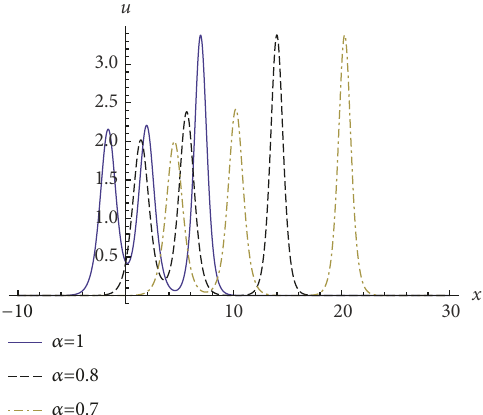
Figure 6: Fractional two-solitons determined by solution (44) at 𝑡 = 3 .